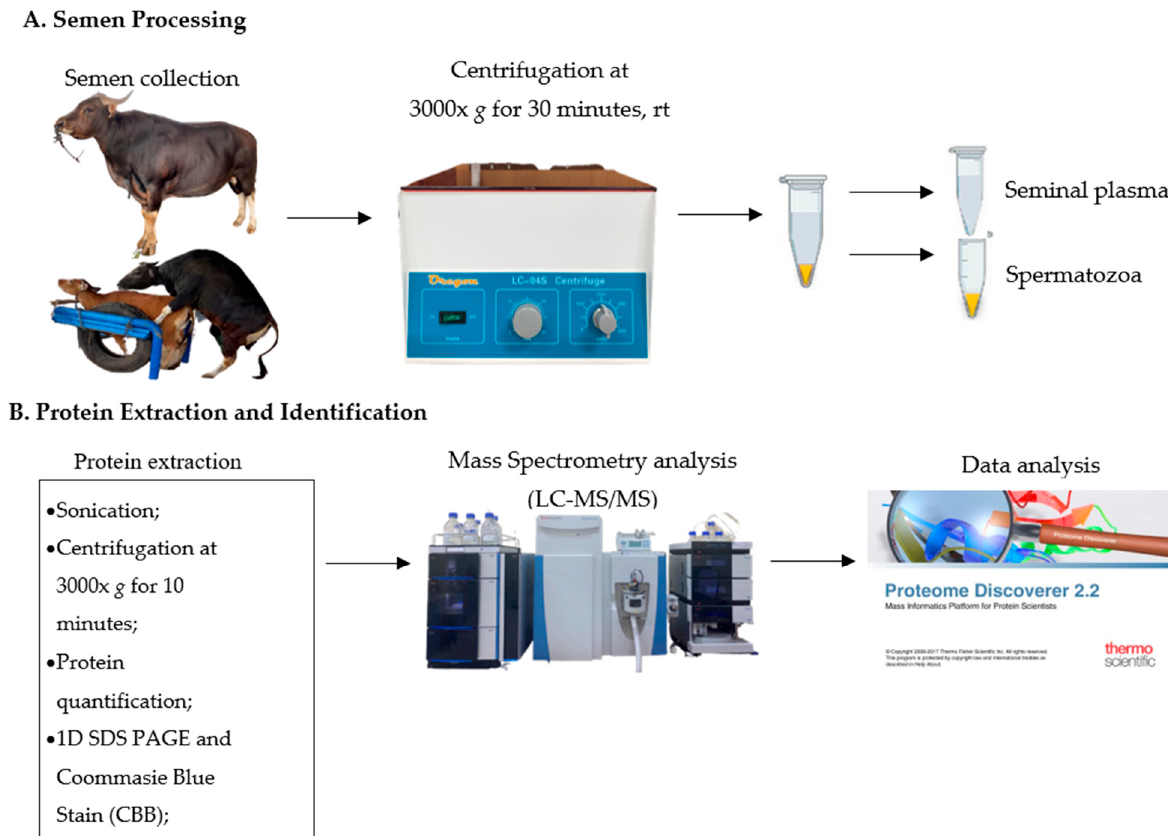
Figure 1. Scheme of the proteomic analysis of Bali bull seminal plasma. ( a ) Semen collection process for Bali bulls. ( b ) Protein extraction and identification.